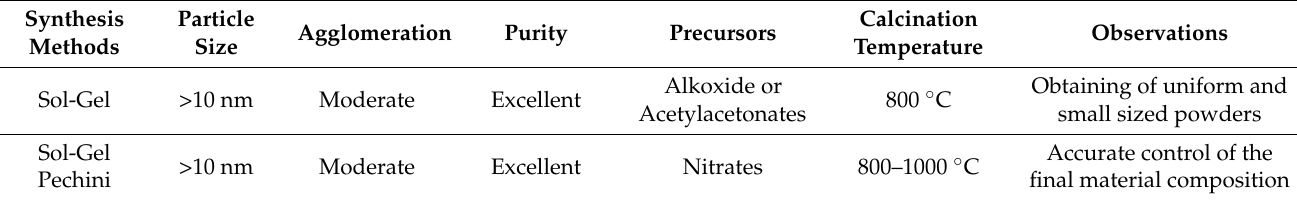
Table 1. Main characteristic of methods for synthesis by Sol-Gel.